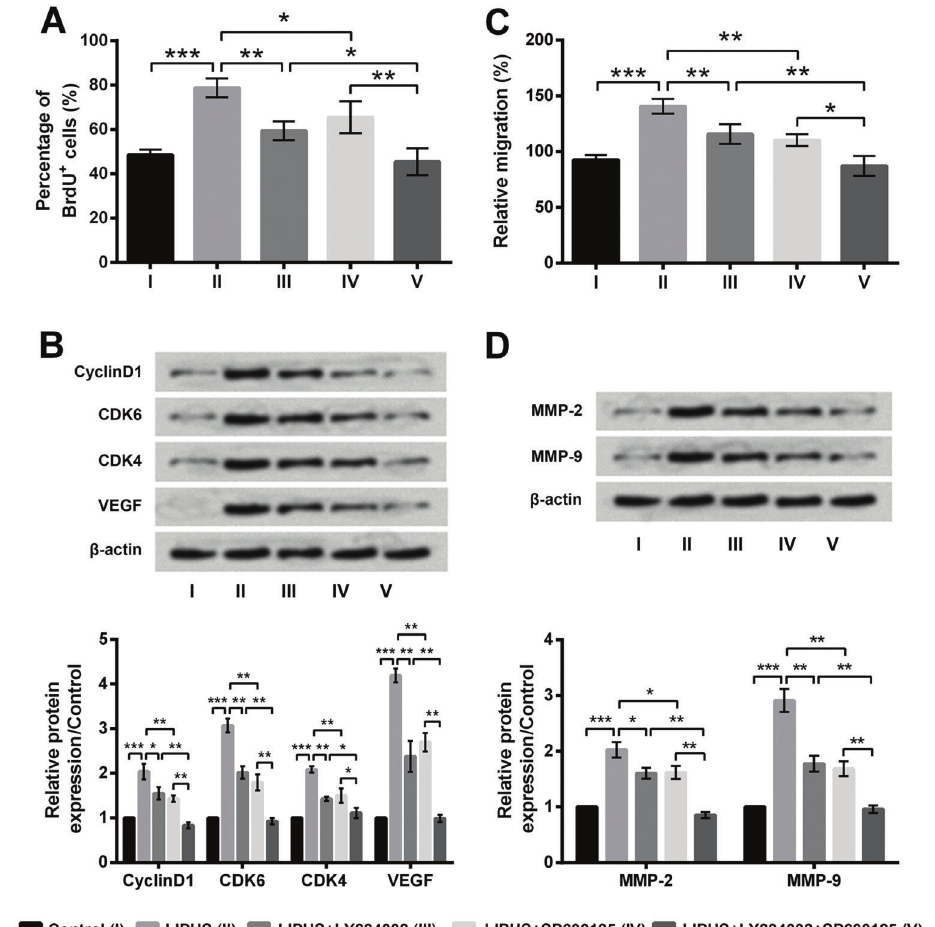
Figure 5. Low-intensity pulsed ultrasound (LIPUS) promoted proliferation and migration of HaCaT cells via the PI3K/AKT and JNK pathways. A , Percentage of BrdU positive cells was evaluated by BrdU incorporation assay. B , Expression of proteins associated with proliferation was evaluated by western blot. C , Relative migration was determined by the Transwell assay. D , Expression of proteins associated with migration was evaluated by western blot. Data are reported as means ± SD of three independent experiments. *P o 0.05, **P o 0.01, ***P o 0.001